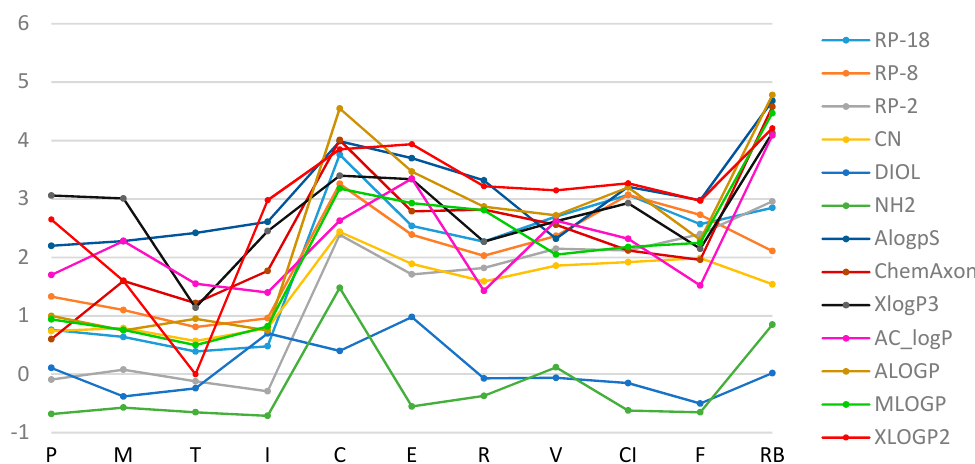
Figure 4. A plot of the relationship of R M0 values for the tested substances obtained experimentally (in the acetone/water mobile phase) and by calculation methods.